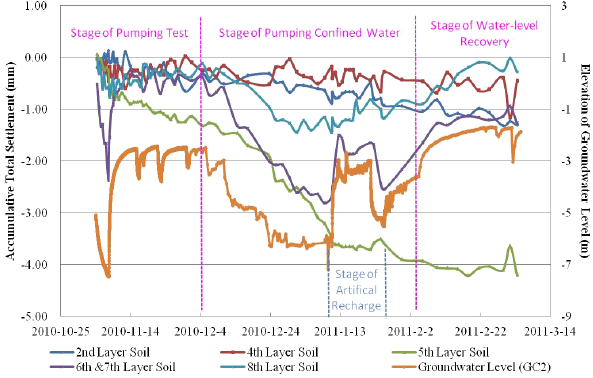
Figure 3. Duration graphical chart of soil laminar settlement and artesian head.